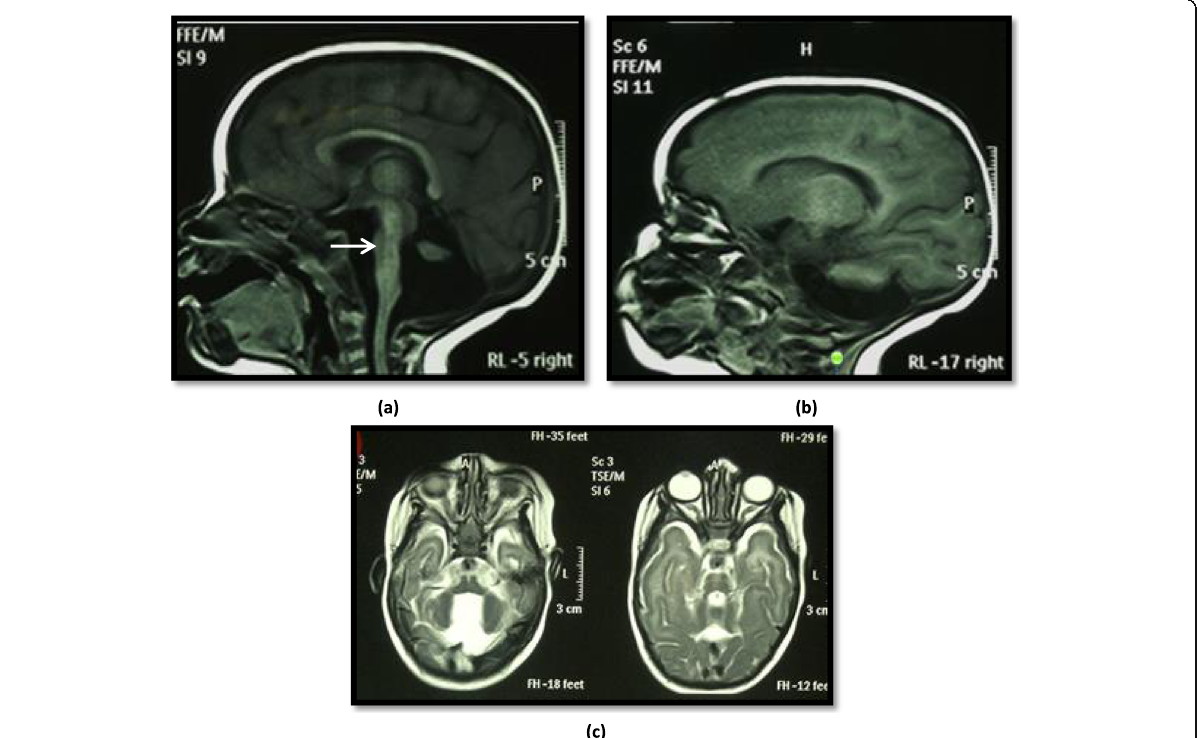
Fig. 2 A 2.5-year-old female patient with delayed motor and mental development. a , b Mid-sagittal and parasagittal T1-weighted and c axial T2- weighted MRI images show global severe cerebellar hypoplasia (marked reduction in size of both cerebellar hemispheres, hypoplasia of inferior cerebellar vermis with relative preservation of the superior midline vermis resulting in a characteristic “ dragonfly ” appearance) and small pons with flattened anterior surface (arrow). Final diagnosis: pontocerebellar